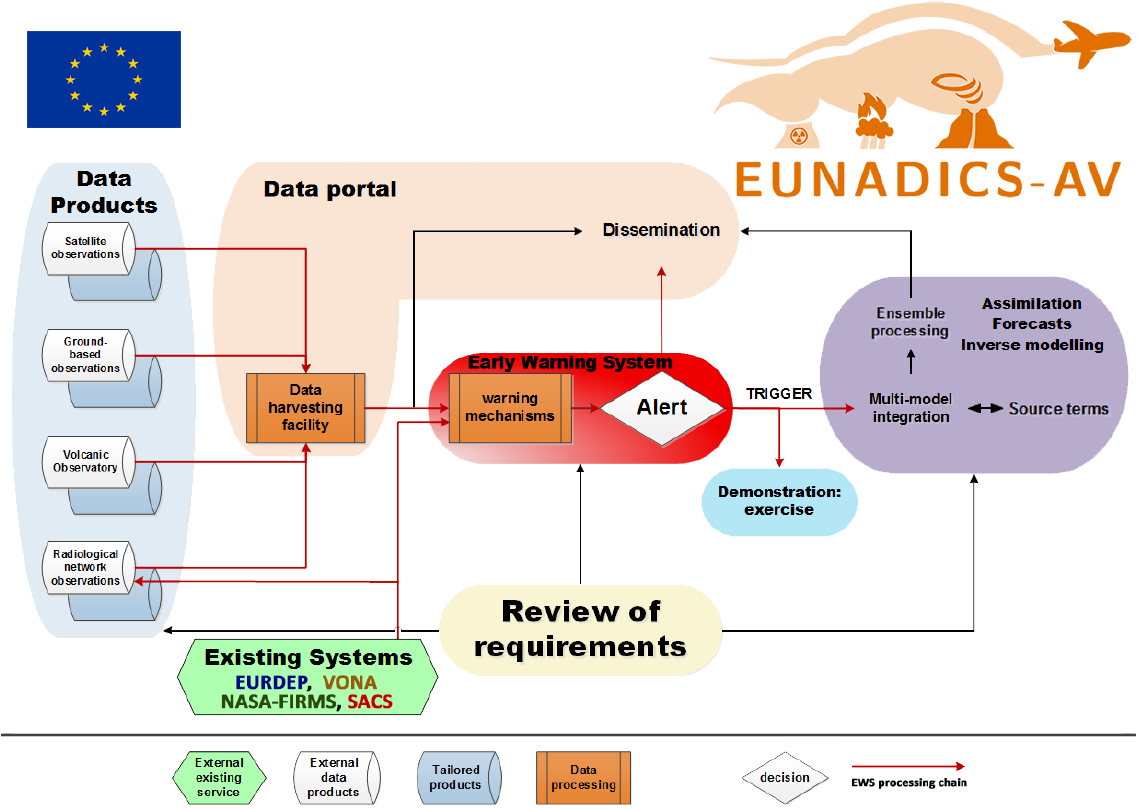
Figure 1. Overview of EUNADICS-AV activities with separation into blocs. NASA FIRMS: Fire Information for Resource Management System. SACS: Support to Aviation Control Service. VONA: Volcano Observatory Notice for